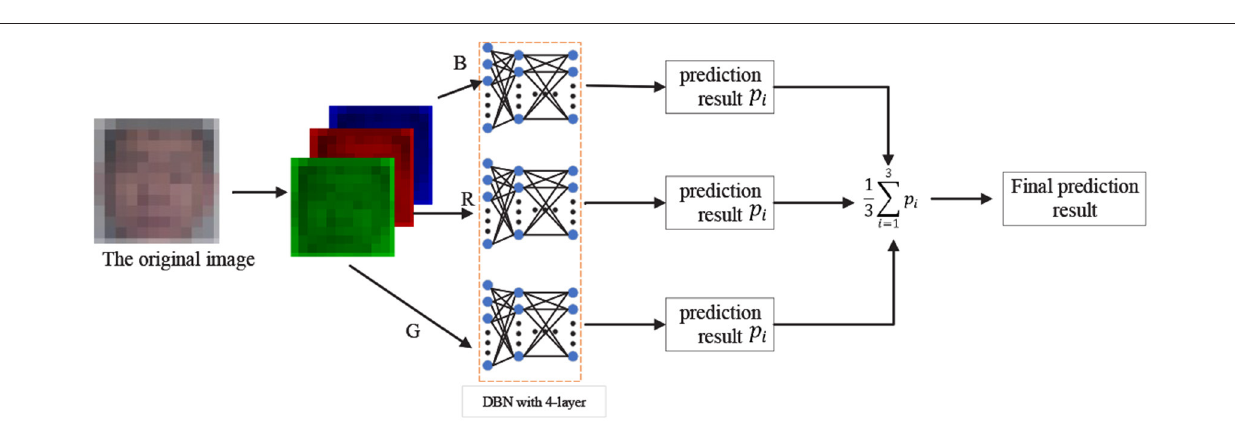
FIGURE 4 | 2D static appearance deep